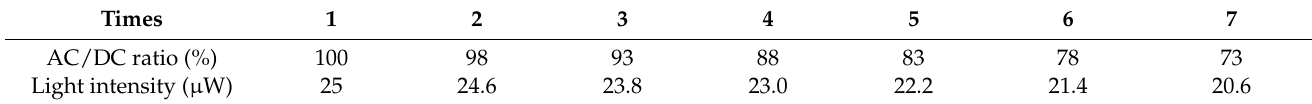
Table 1. Light intensity results under different AC/DC ratios.